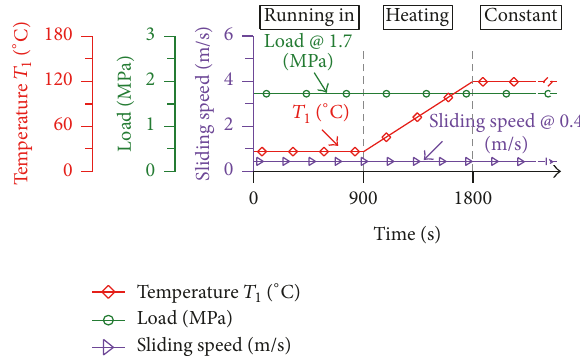
Figure 5: Input parameters of the temperature load test performed with the JBA test